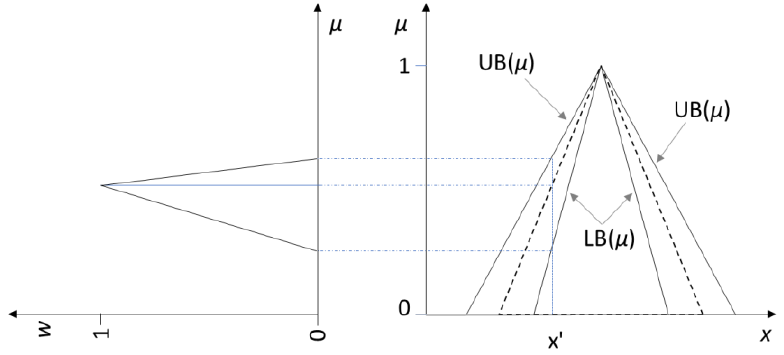
Figure 4. An example of type-2 fuzzy set. The original type-1 fuzzy set is the dashed triangular set. The lower (LB) and upper (UB) bounds define the footprint of uncertainty. The plot on the left shows the trend of the secondary membership ( w ) when 𝑥 = 𝑥′ .